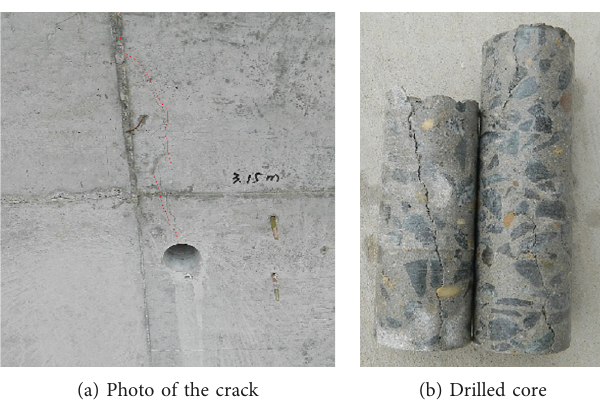
Figure 3: Crack “L1” and its drilled